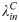
Therapeutic strategies (Localization of the glioma cells).(A-C) Effect of the different strength λinC of the chemotactic source on migration patterns of a glioma cell (wild type; blue curves) at the final time t = 392 min: λinC = 0.14 (A), 0.82 (B), 1.64 (C). Red star (*) = a chemotactic source, red circles = the initial configuration of a glioma cell. (D-F) Profiles of the chemoattractant at the final time for the corresponding three cases in (A-C). (G) Anti-invasion treatment efficacy for those three cases in (A-C).